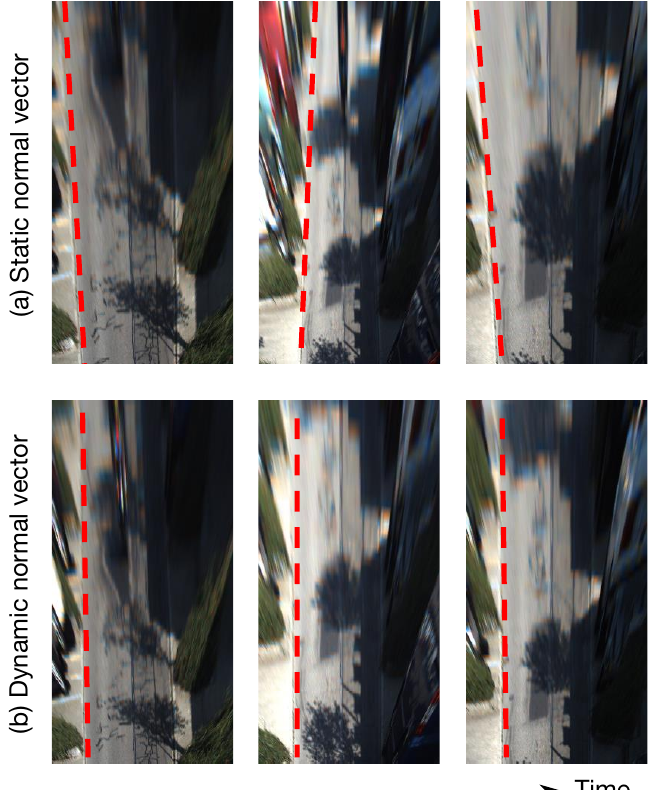
Figure 7. Visual comparison of IPM images using ( a ) static normal vector based on fixed extrinsic calibration, and ( b ) dynamic normal vector using our proposed method. The odometry input is formed by the monocular version of ORB-SLAM2. We can clearly find that the road edges are not parallel with each other with a static normal vector. Based on the dynamic normal vector from our method, the road edges in IPM images are more parallel and